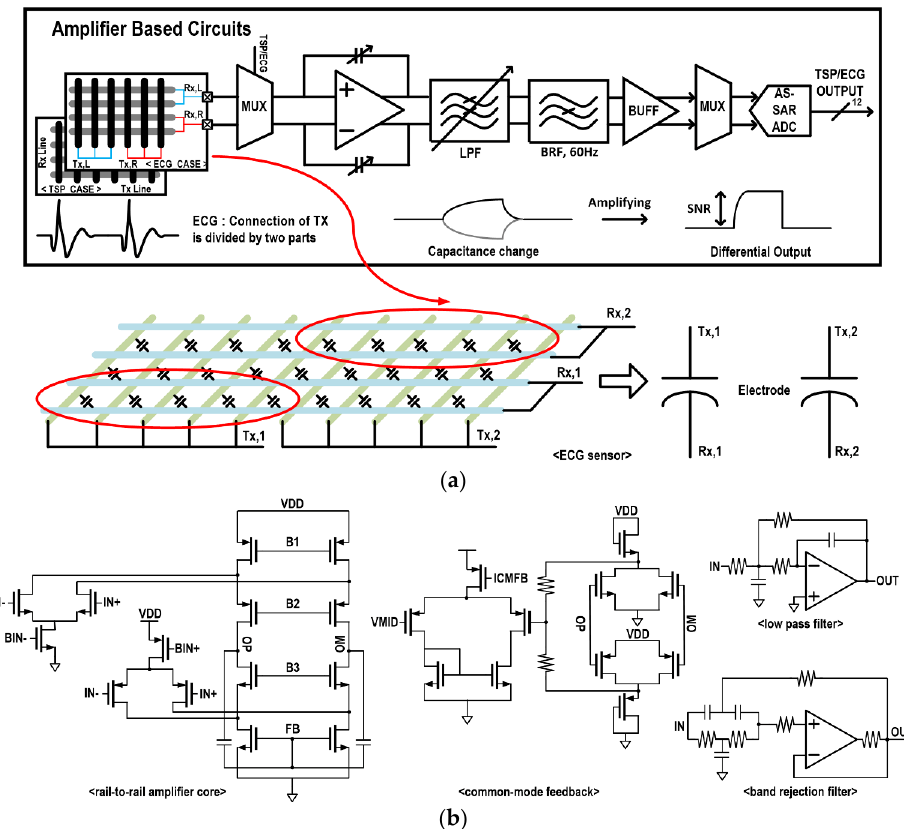
Figure 4. ( a ) Amplifier-based multi-sensor interface configuration, and ( b ) readout